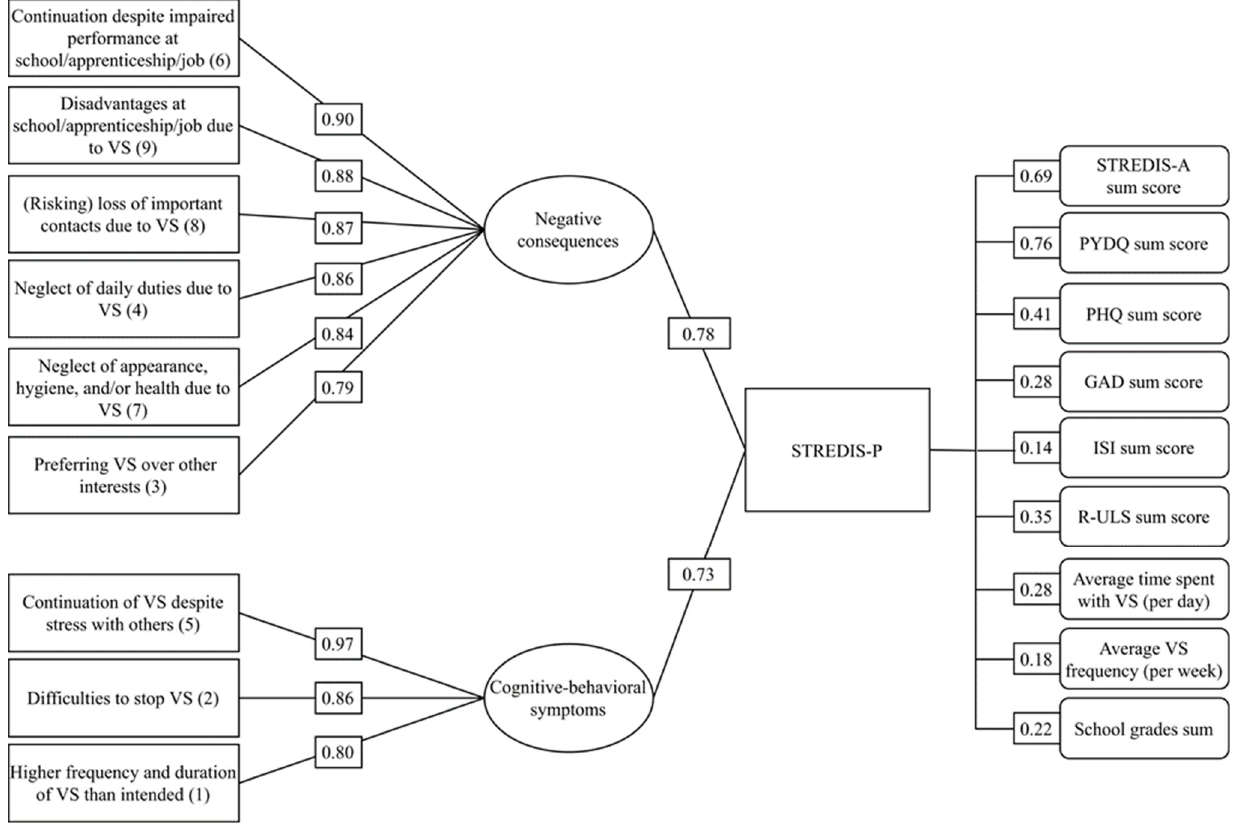
Figure 1. CFA factor loadings on the latent STREDIS-P factor 1 (negative consequences) and STREDIS-P factor 2 (cognitive-behavioral VS symptoms) are shown on the left. In the center the explained variance proportions of the two factors are depicted. Spearman (average VS frequency) and Pearson correlation coefficients (all other) of the STREDIS-P sum score with criteria are presented on the right. All factor loadings and correlations were significant with p values < 0.001. Abbreviations: STREDIS-P = Streaming Disorder Scale for Parents; STREDIS-A = Streaming Disorder Scale for Adolescents; PYDQ = Parental Young Diagnostic Questionnaire; PHQ = Patient Health Questionnaire; GAD = Generalized Anxiety Disorder Scale; ISI = Insomnia Severity Index; R-ULS = Revised UCLA Loneliness Scale; VS = video